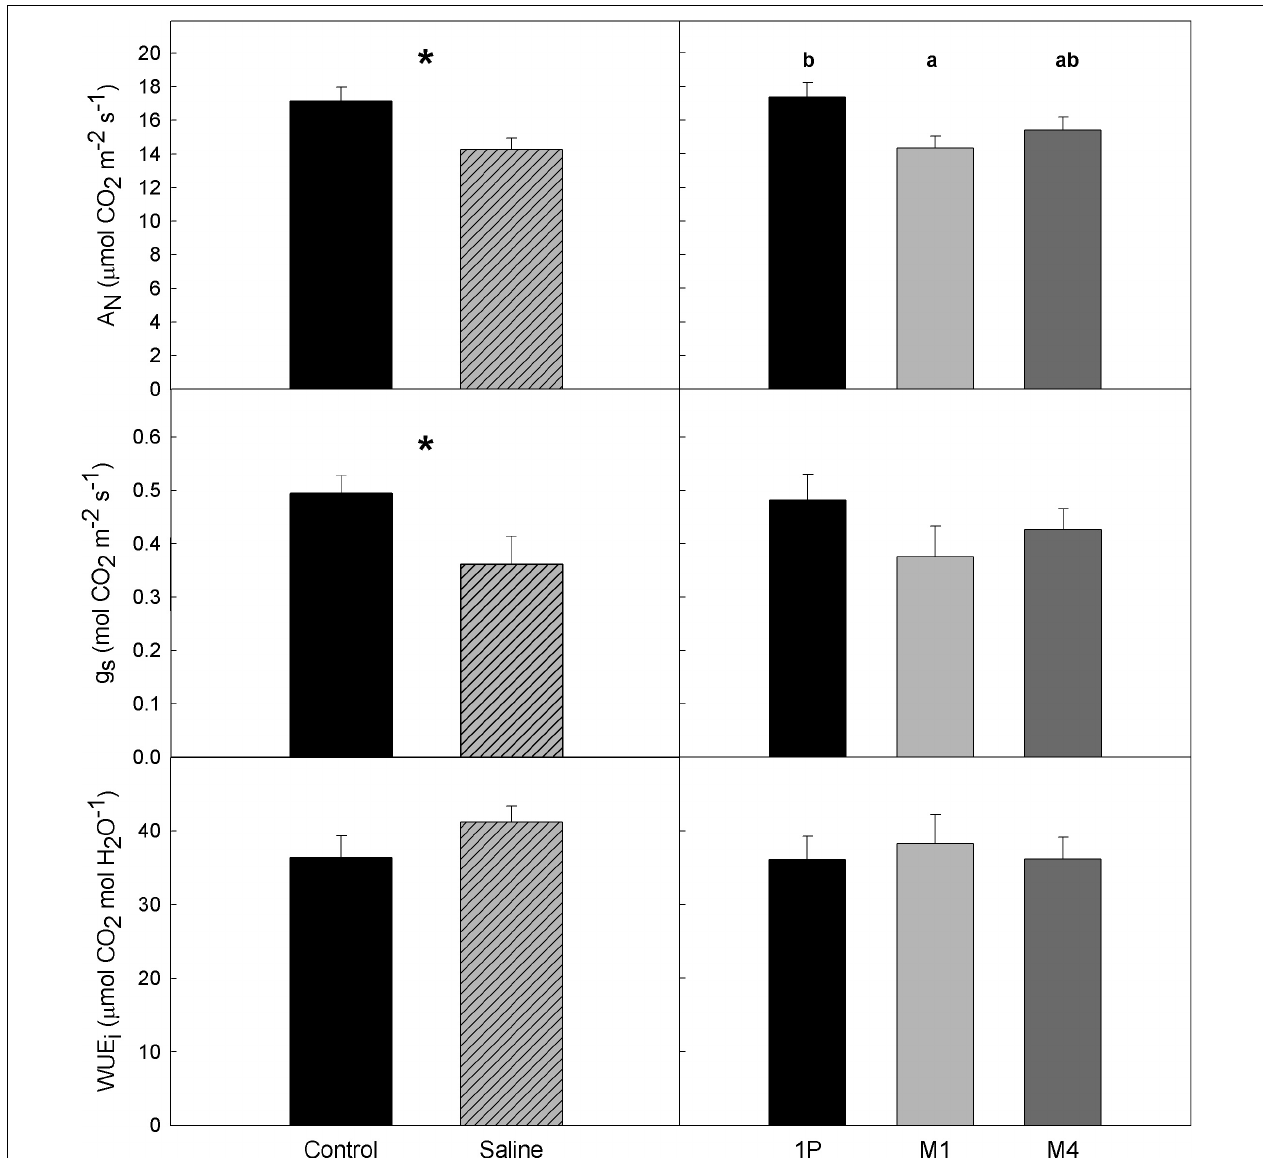
FIGURE 2 | Average values of gas exchange parameters in a Tempranillo vineyard grafted onto M1, M4, and 1103-Paulsen (1P) rootstocks subjected to different water quality (C, control and S, saline irrigation) on DOY 233 of 2019 in Valencia, Spain. A N , net photosynthesis; g s , stomatal conductance; WUE i , intrinsic water use efficiency. Data are averages and standard errors of 18 and 12 measurements per water quality and rootstock, respectively. Within each parameter, asterisks or letters denote significant differences between water quality treatments or rootstocks at p < 0.05 (Duncan test), respectively.